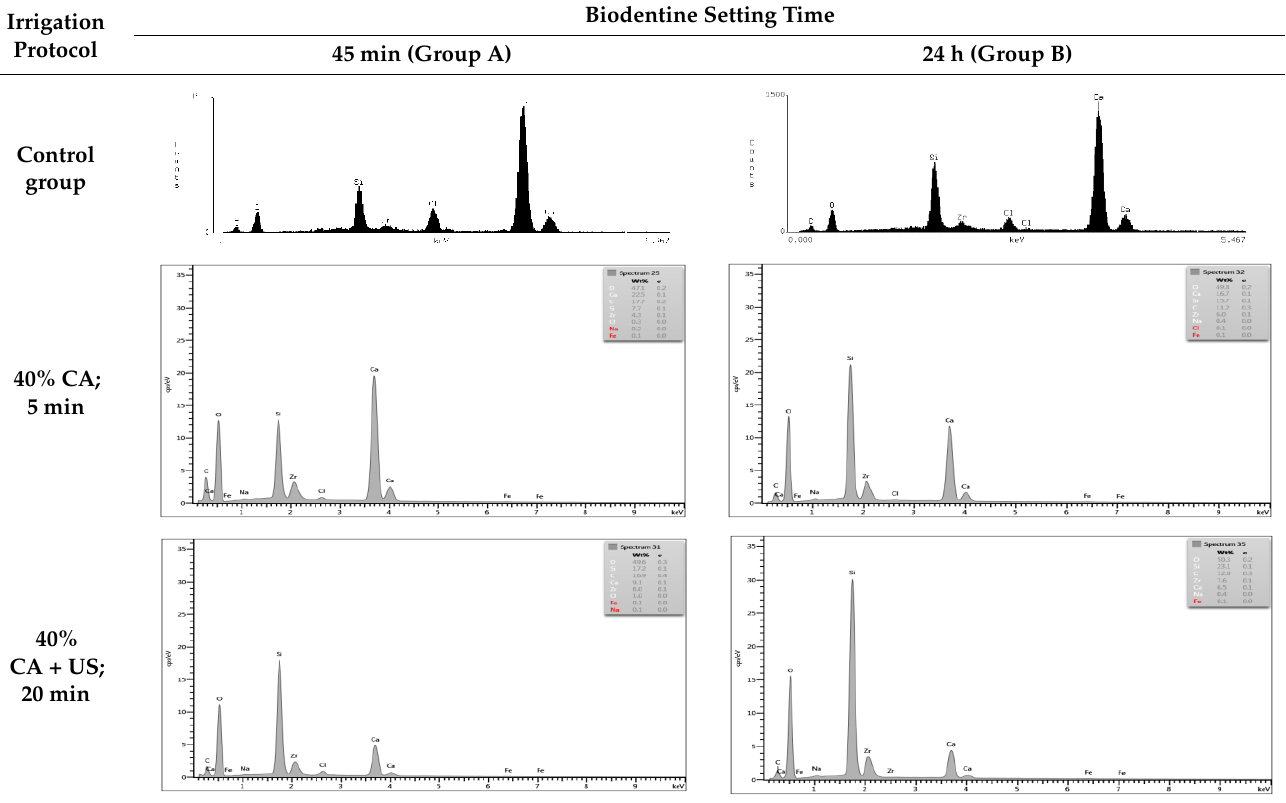
Table 1. Energy dispersive spectrograms of Biodentine control and boundary investigated samples.